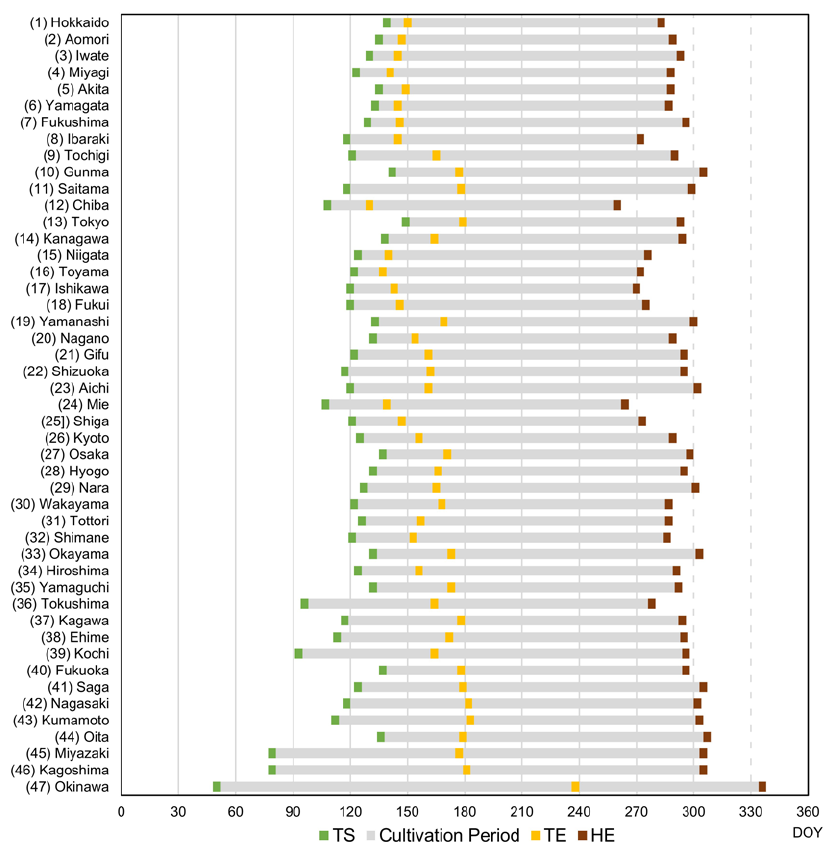
Figure 1. Typical dates of rice cultivation in the 47 prefectures of Japan. The day of the year (DOY) of the Transplant Start (TS), Transplant End (TE), and Harvest End (HE) dates was obtained by averaging the dates for 2015–2017 published by MAFF.